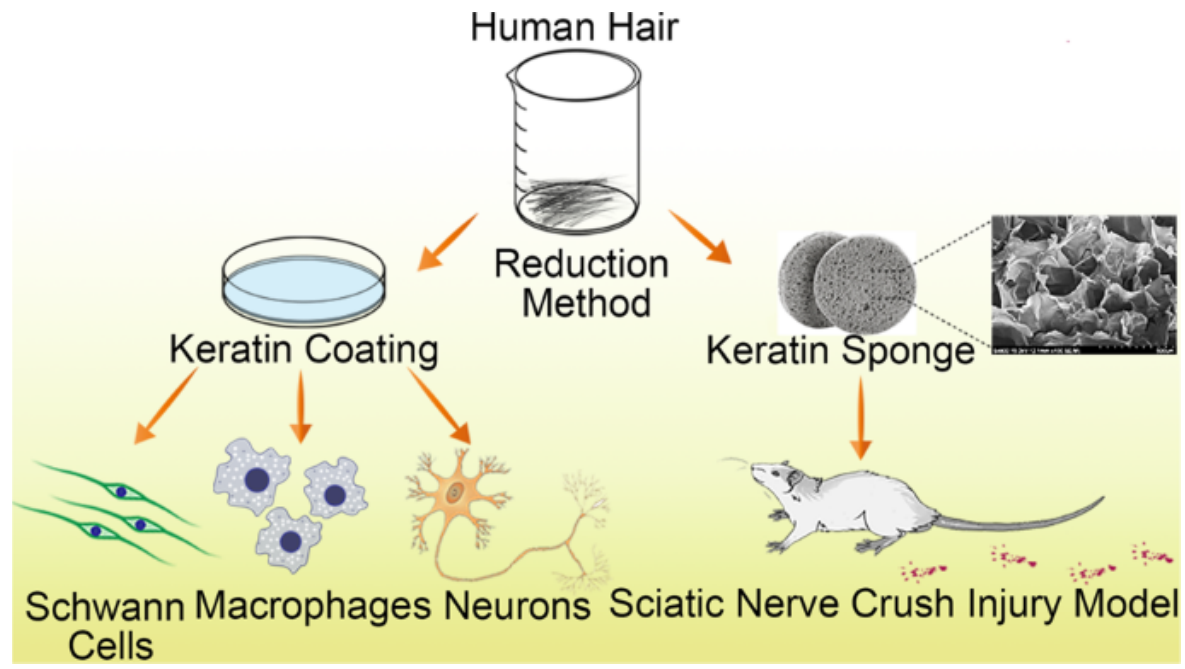
Figure 3. Schematic illustration of keratin sponge application for nerve regeneration following sciatic nerve crush injury. Keratin biomaterial promoted Schwann cell proliferation and regulated macrophage inflammatory cytokines and elongation of the axon in dorsal root ganglion neurons in vitro. Likewise, in vivo studies demonstrated that keratin sponge restored motor function after sciatic nerve crush injury. Reprinted with permission from Gao, J.; Zhang, L.; Wei, Y.; Chen, T.; Ji, X.; Ye, K.; Yu, J.; Tang, B.; Sun, X.; Hu, J. (2019). Copyright 2019 Journal of Materials Science: Materials in Medicine, Springer Nature [109].